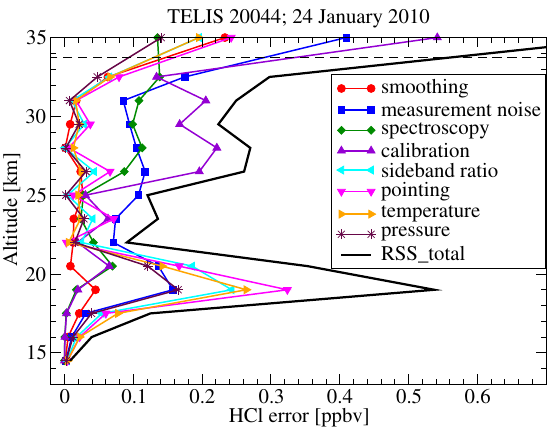
Figure 7. Individual estimates of smoothing, noise, and model parameters errors for HCl retrieval. The estimated errors correspond to TELIS FIR measurement 20044 during the 2010